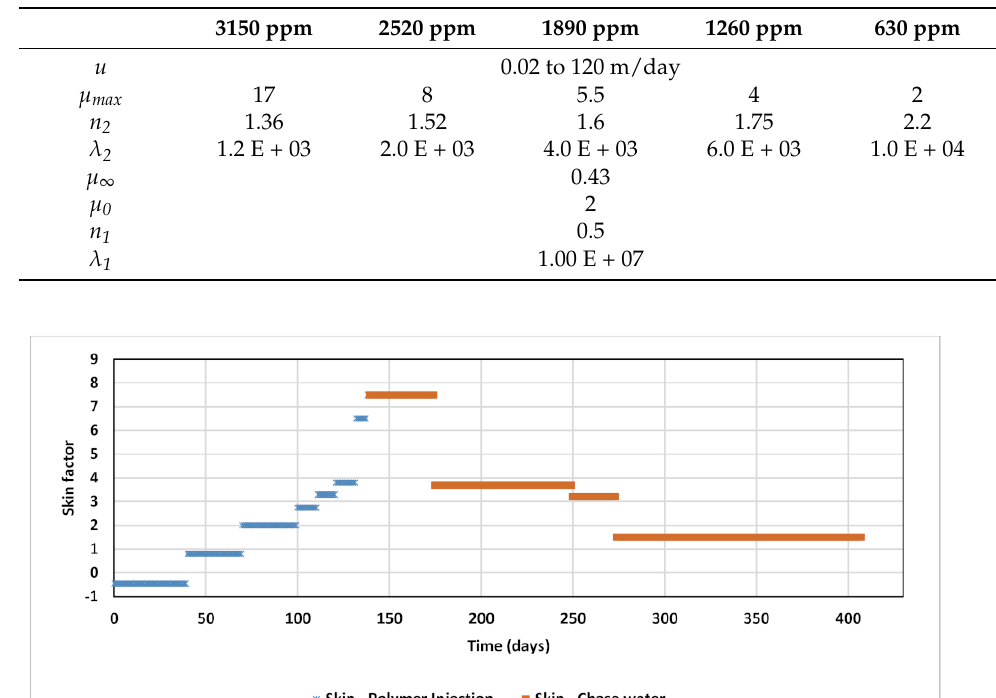
Figure 22. Rheology curves used in history matching polymer injection. Table 5. Extended Carreau equation parameters used to create matching rheology curves.